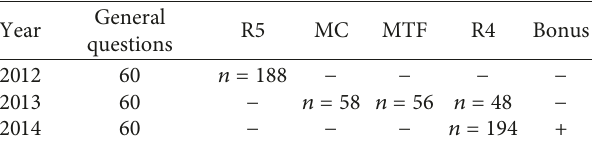
Table 1: Overview of study design, year, mode of questions, and